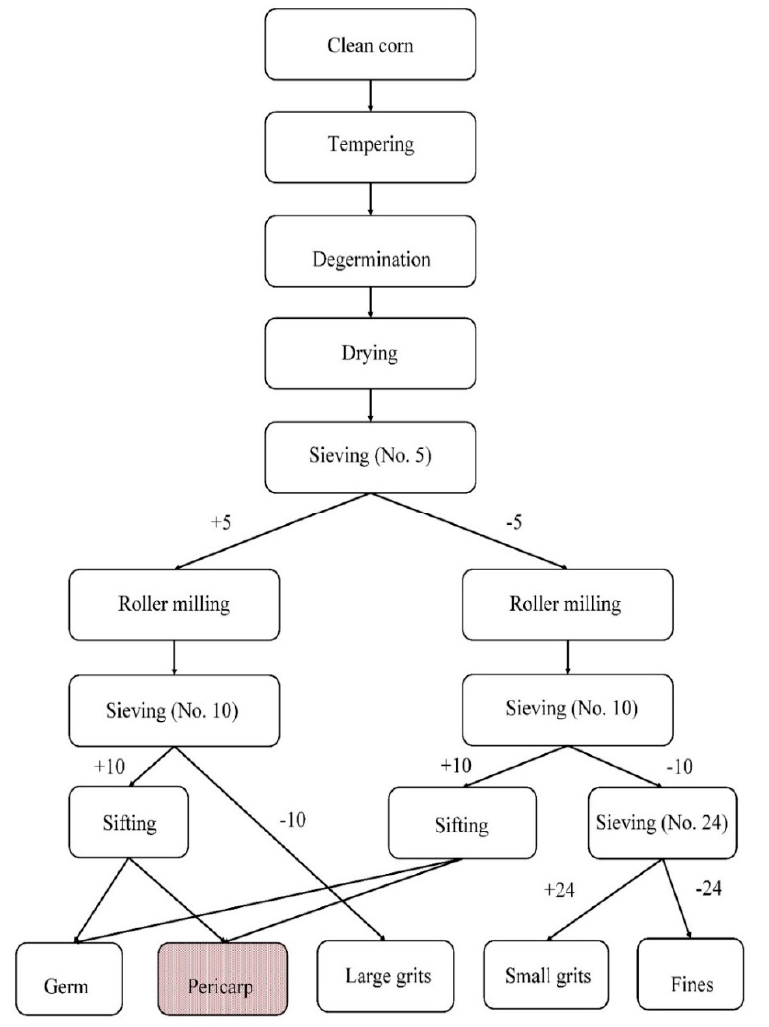
Figure 1. Process schematic of lab-scale dry milling protocol. The numerals represent the size of screen used, and + and – symbols represent the fractions recovered at the top and under those sieves, respectively (adapted from Rausch 2009) [64].